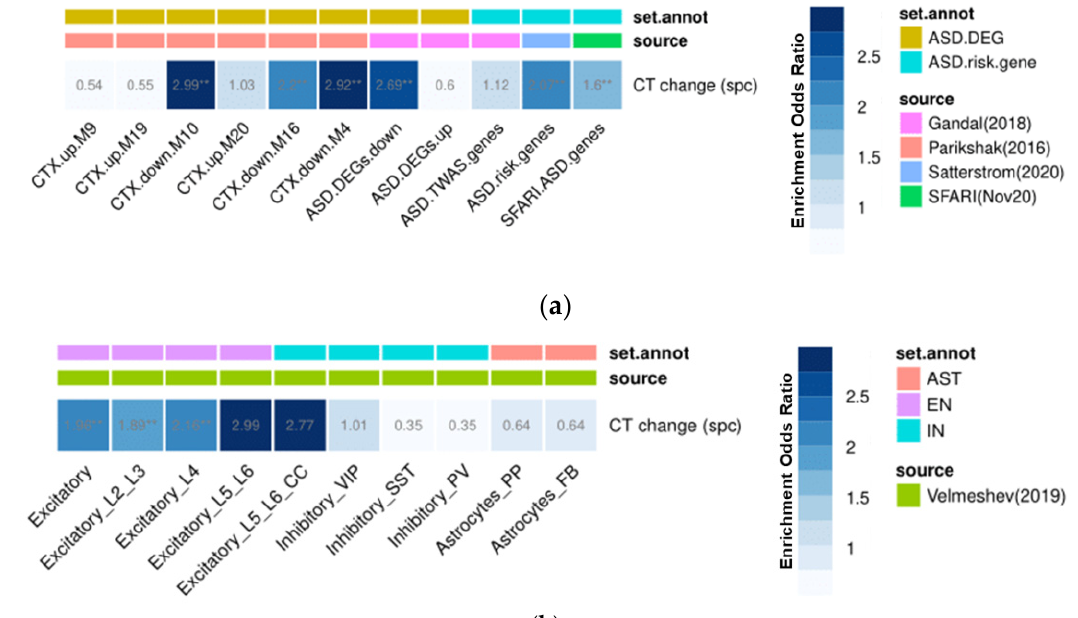
Figure 5. Genomic and cellular underpinnings of neurodevelopmental deviations in the change in Cortical Thickness (CT spc ) in ASD. The enrichment analysis of genomic underpinnings of the symmetrized percent change in CT (CT spc ) was based on the t -map of statistical between-group differences in the developmental change in CT during adolescence in individuals with autism spectrum disorder (ASD), relative to neurotypical controls (Figure 2a) and various gene sets. ( a ) The significant odds-ratios (OR) at an FDR-rate p value of < 0.05 resulting for genes expressed in the t -map. Gene sets were subdivided into sets with differential gene expression in ASD (ASD.DEG) and into sets containing ASD risk genes (ASD.risk.gene). Gene set annotation (set.annot) and labeling were determined by their original publication [42–45]. Abbreviations: up: upregulated expression in ASD, down: downregulated expression in ASD, CTX: cortex, DEG: differential gene expression, **: significant odds-ratios at an FDR-rate p value of < 0.05. ( b ) The set with an enrichment of genes particularly expressed in the upper layer cortex neurons and crucial for brain development, as reported by Velmeshev et al. (2019). Annotations were defined by the three cell types: astrocytes (AST), excitatory neurons (EN), and inhibitory neurons (IN). Abbreviations: L2–6: cortical layers, CC: cortico-cortical, SST: somatostatin, PV: parvalbumin, PP: protoplastic, FB: